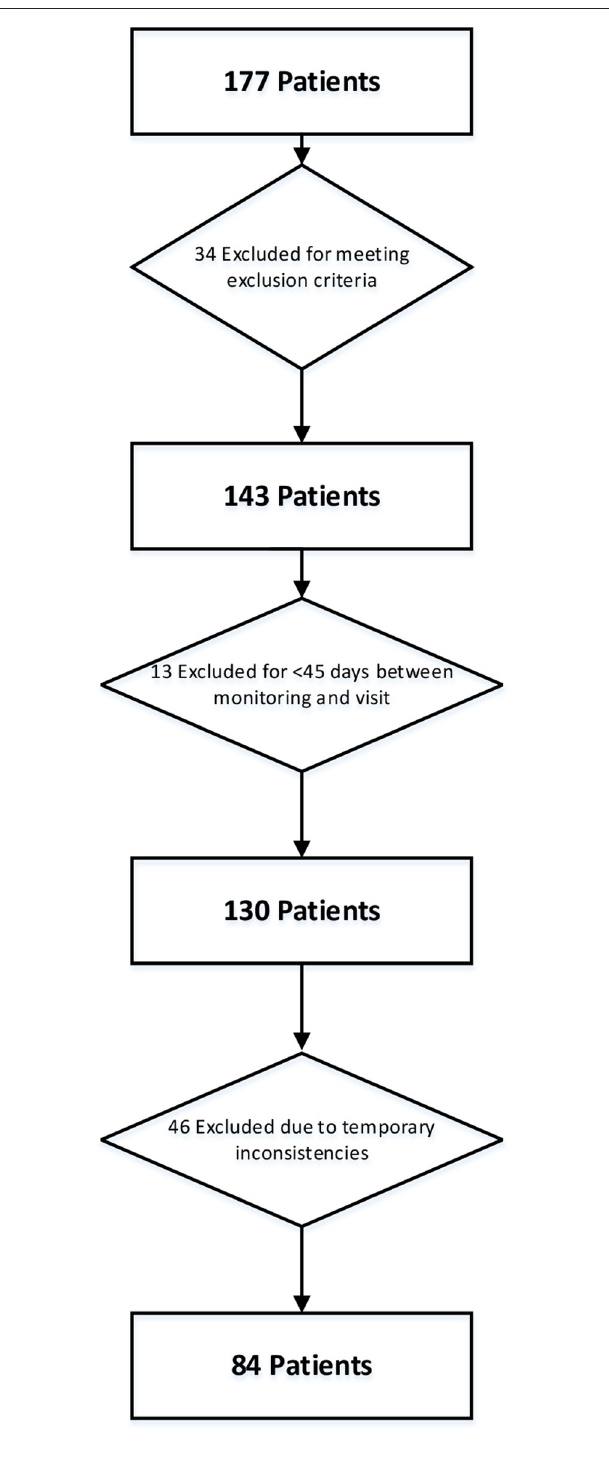
FIGURE 1 | Diagram of the patient selection process for the subanalysis.